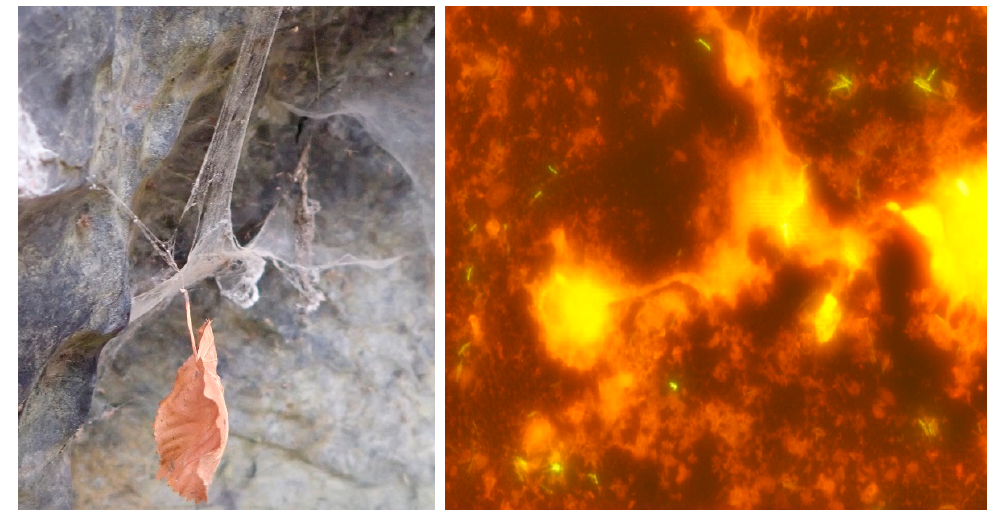
Figure 1. Dust in spiders’ nests ( left ) is often contaminated by mycobacteria ( right ); after the fluo ‐ rescent staining of the dust sample (magnified 1000 times) yellow ‐ coloured, rod ‐ shaped mycobac ‐ terial cells were observed in this microscopic field of view. This sample was culture ‐ positive for M. triviale .